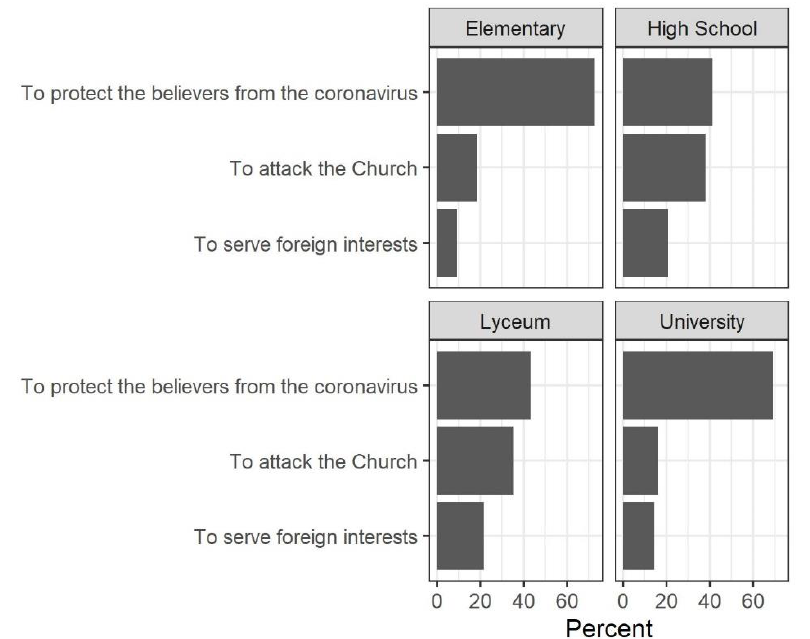
Figure A3. Cross-tabulation of attitudes of believers for closing of Churches by education (% by education). X 2 = 25.142, df = NA, p = 0.001 (Pearson’s Chi-squared test with simulated p -value based on 2000 replicates).